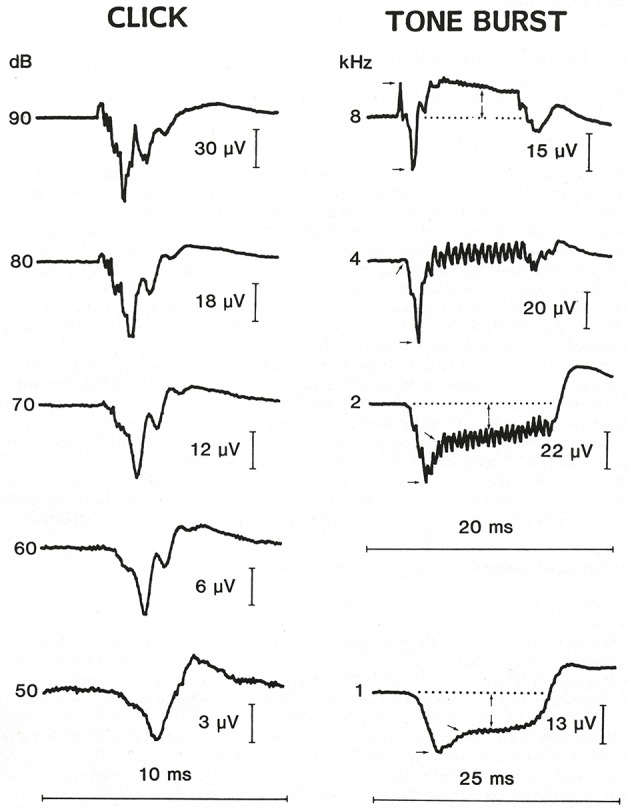
Transtympanic SP responses to a 90 dB click and to 10 ms 1, 2, 4, and 8 kHz tone bursts with 8 kHz showing a reversed polarity. The magnitude is measured in microvolts from the midpoint of the prolonged SP to the baseline (Dauman and Aran, 1991). Reproduced from Dauman and Aran (1991).